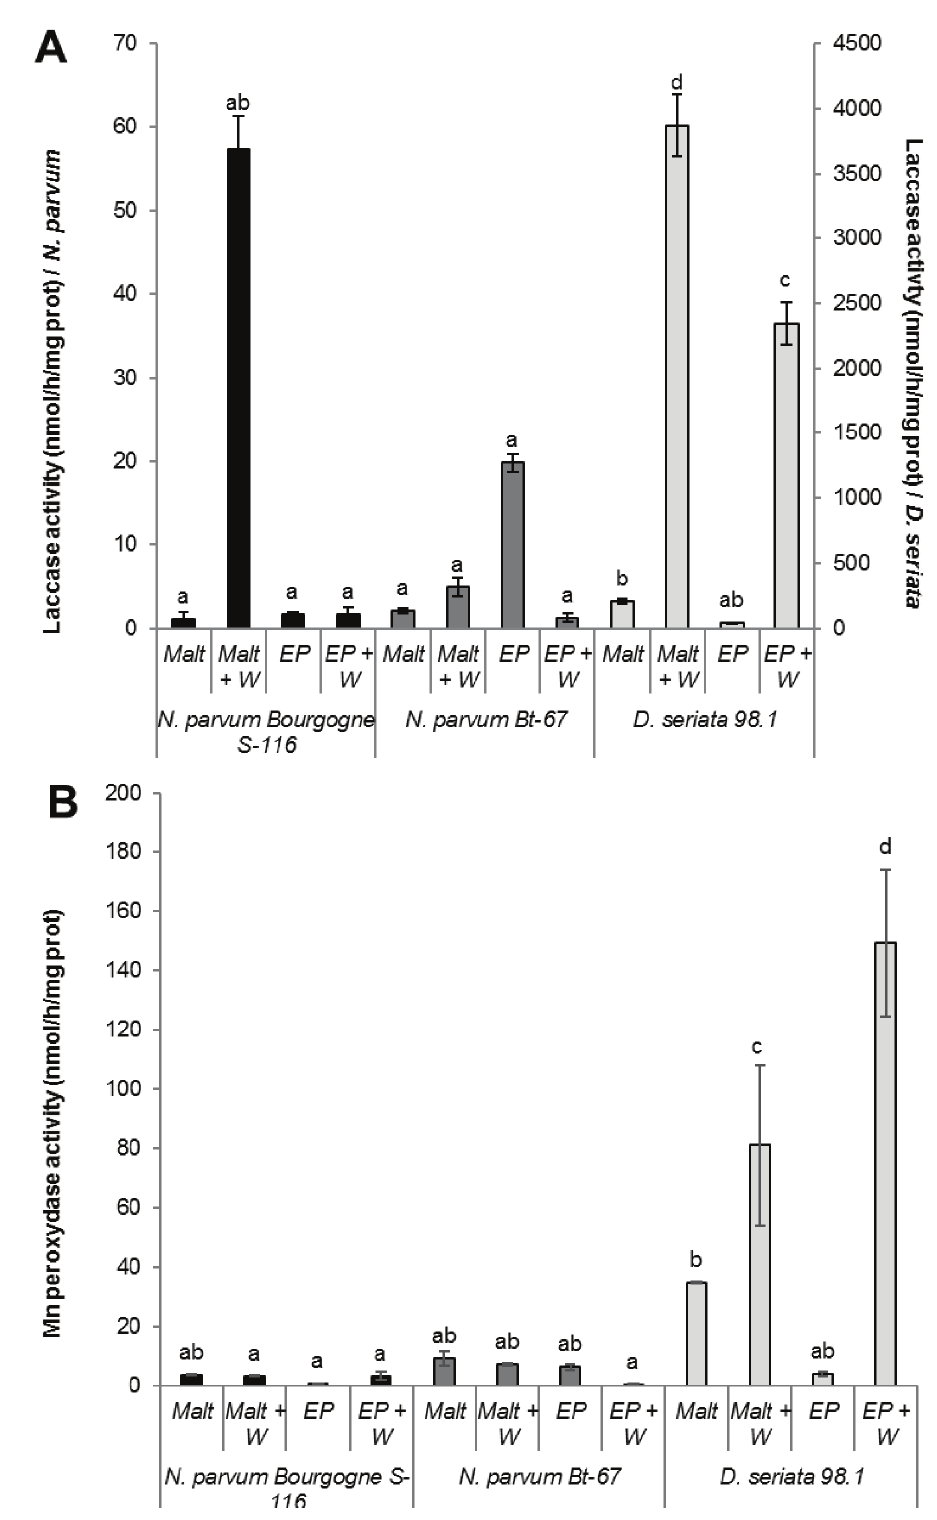
Fig 2. (A) Laccase activity. Oxidation of ABTS in the radical cation ABTS .+ was measuredwith total secreted proteins from N . parvum BourgogneS-116, N . parvum Bt-67 and D . seriata 98.1. Total proteins